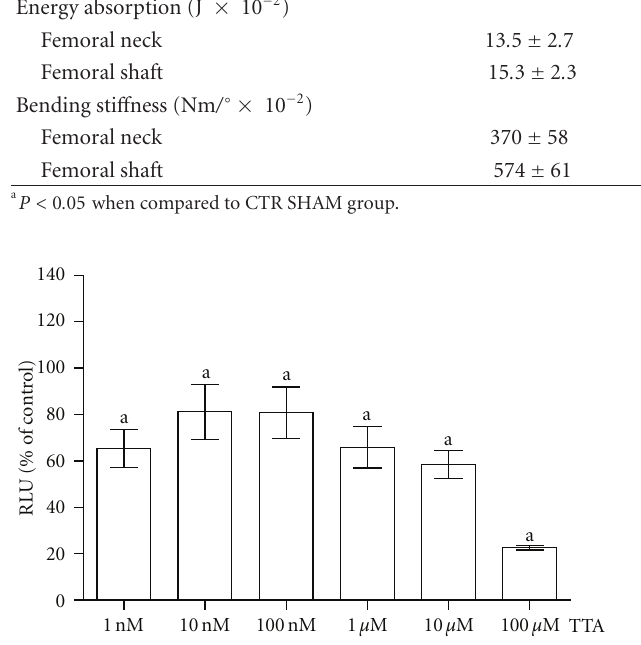
Figure 1: The e ff ect of TTA (1nm–100 μ M) on RAW 264.7 preosteoclast cell proliferation. Data are in mean ± SD and presented as relative light units (RLU) in % of control (untreated cells at same time point), a P < 0 . 05 when compared to control.